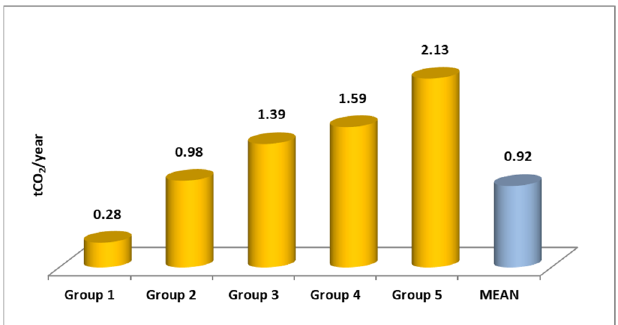
Figure 13. Mean CO 2 emissions per household by group of cities.